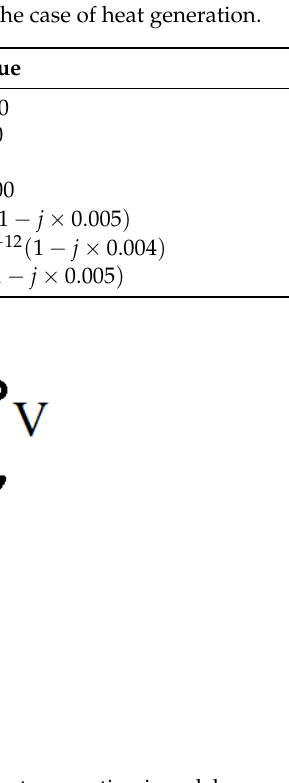
Figure 5. Geometrical parameters for the case of heat generation in a